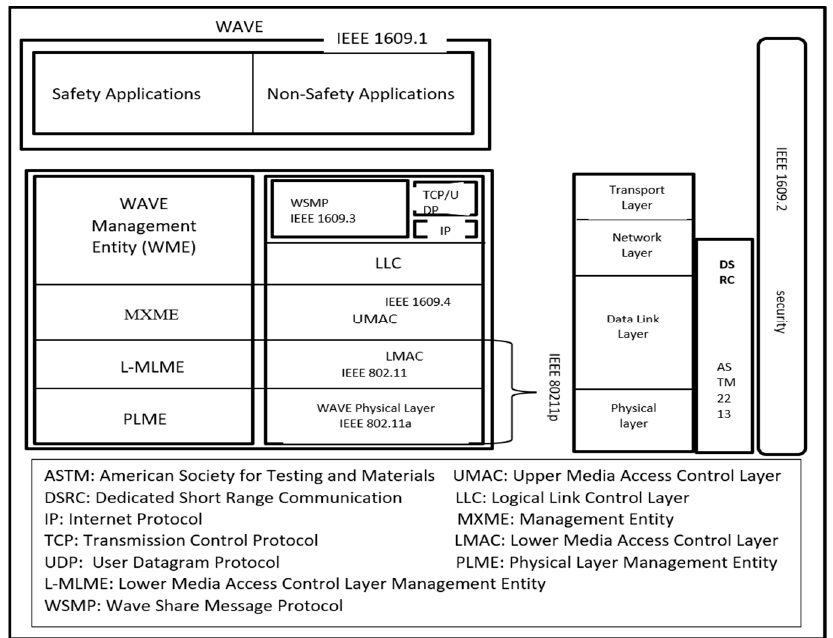
Figure 2. WAVE model.